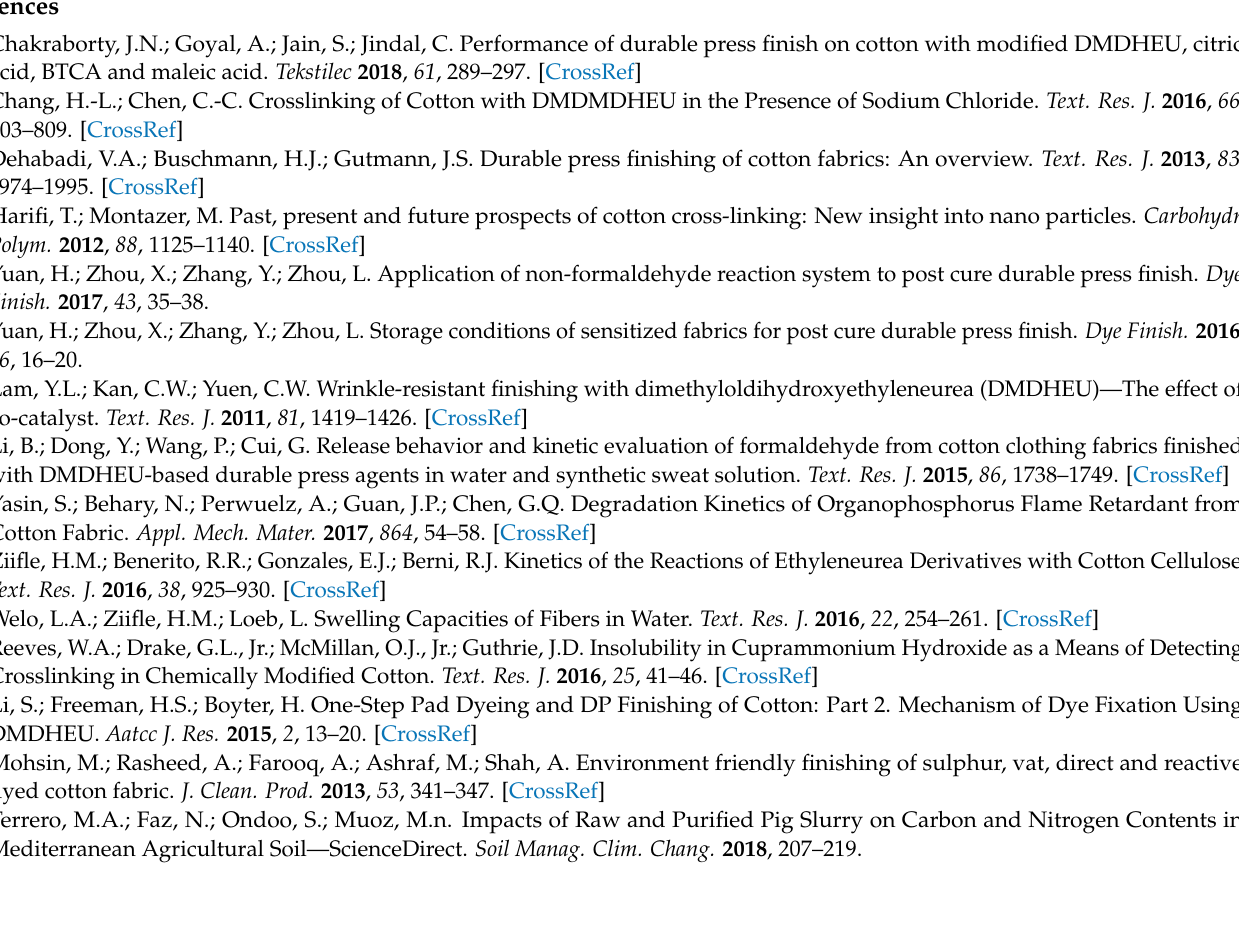
tures, Table S2: WRA (b) with storage time under different storage temperatures, Table S3: ln( Nm − N )/ Nm with storage time under different storage temperatures, Table S4: 1/T and − lnK under different storage